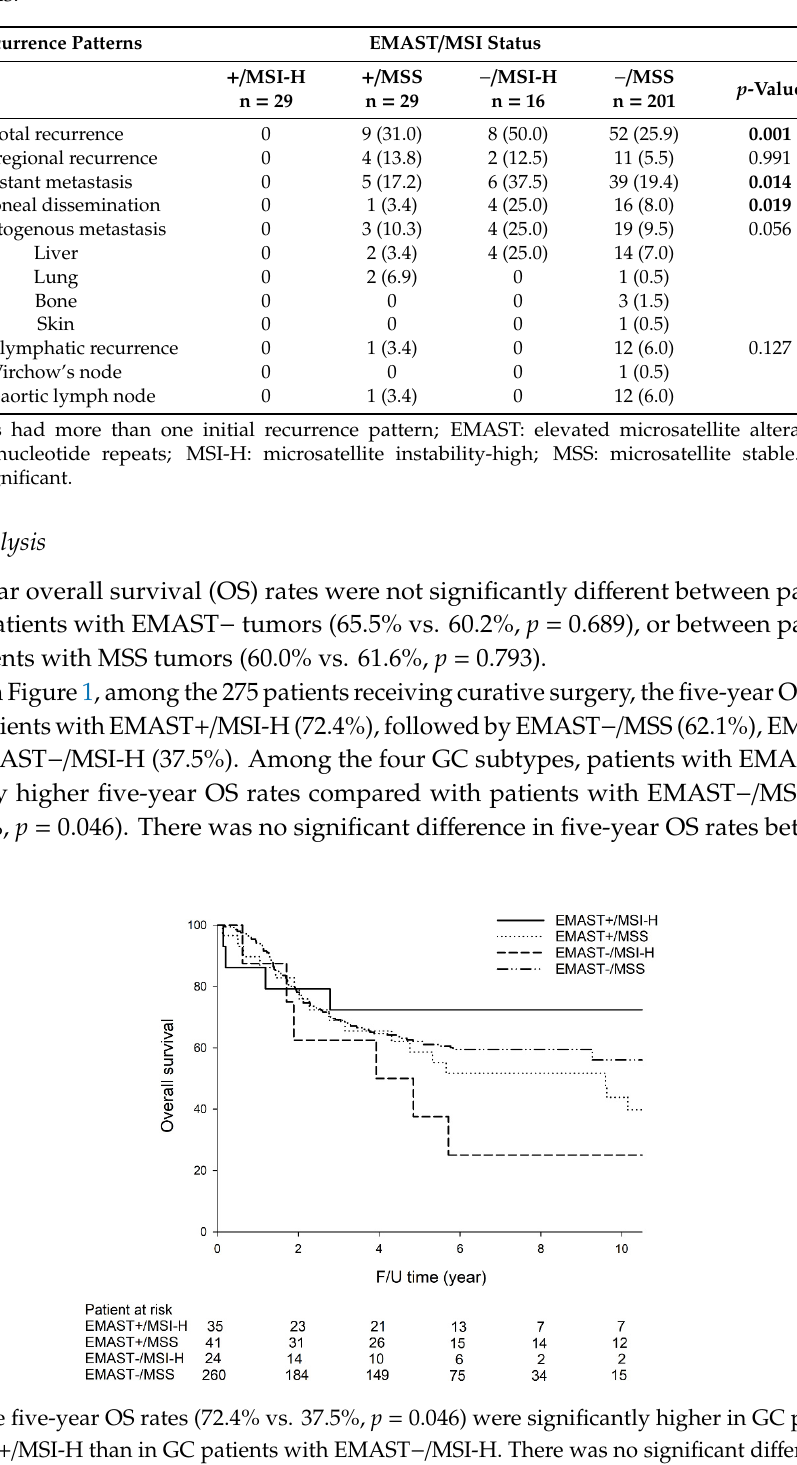
Table 6. The patterns of initial recurrence of gastric cancer after curative surgery, according to EMAST status.